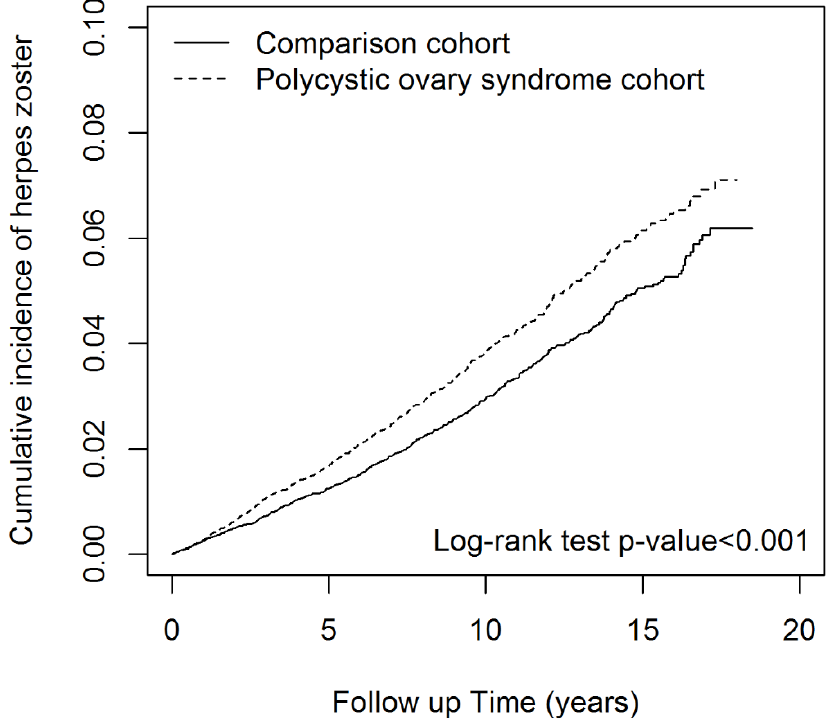
Figure 1. Cumulative incidence of herpes zoster in patients with polycystic ovary syndrome com- pared to